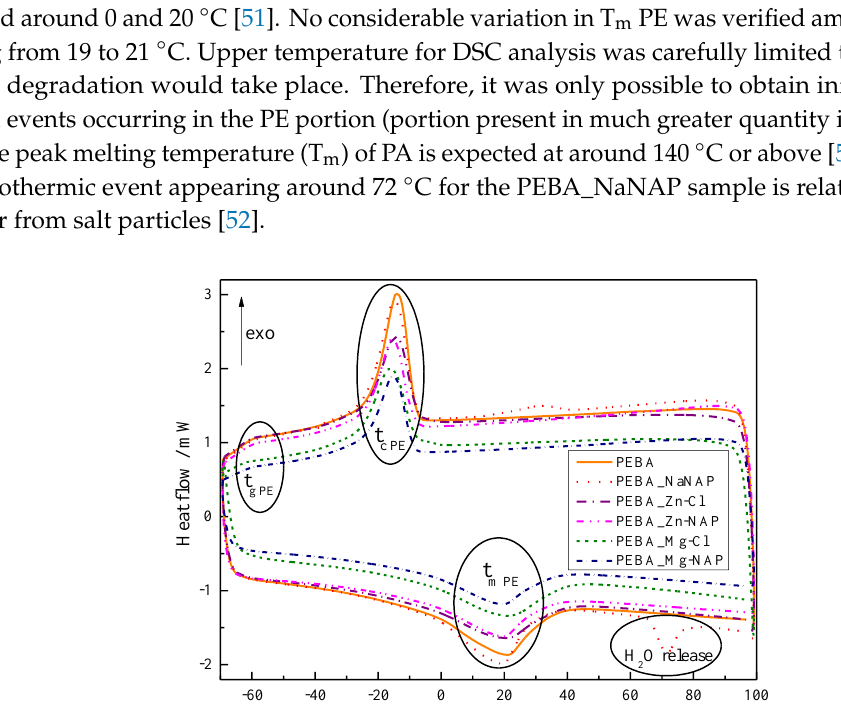
plane, γ = bending out of plane, sc = scissoring and ω = wagging.